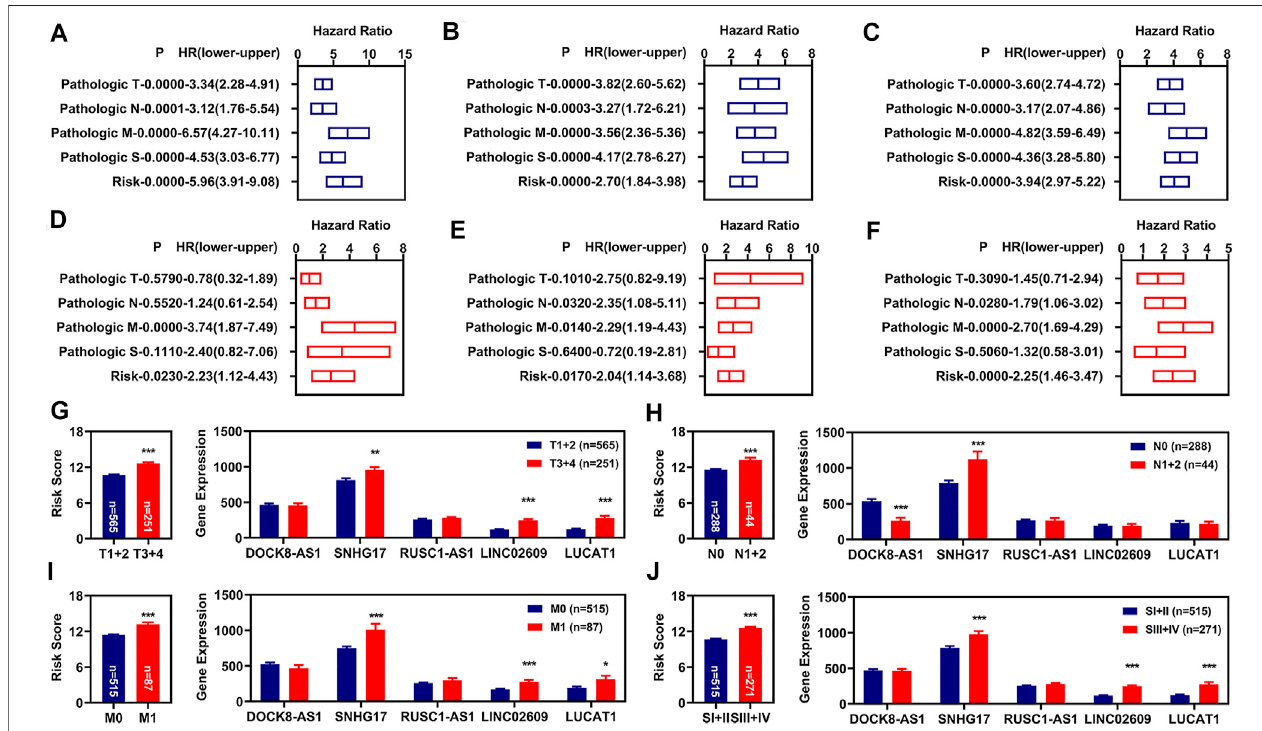
FIGURE 3 | Independent prognosis factors and correlation analyses. (A – C) Univariate Cox regression of prognosis factors in training group (A) , validation group (B) , and entire group (C) . (D – F) Multivariate Cox regression of prognosis factors in training group (D) , validation group (E) , and entire group (F) . (G – J) Correlation of risk values (left) and those 5 FR-DELs (right) with the pathologic T (G) , pathologic N (H) , pathologic N (I) , and pathologic stage (J) . * p < 0.05, ** p < 0.01, *** p < 0.001. FR-DELs, ferroptosis-related differentially expressed